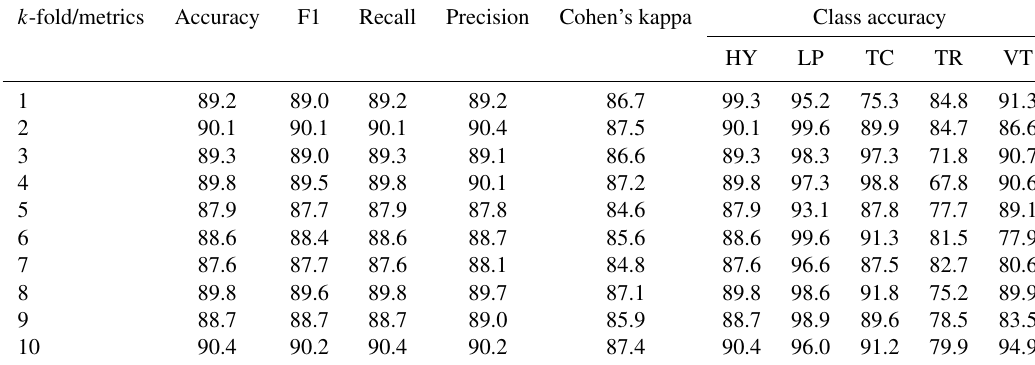
Table 5. Performance of the transfer learning experiments applying k -fold validation. k -fold/metrics